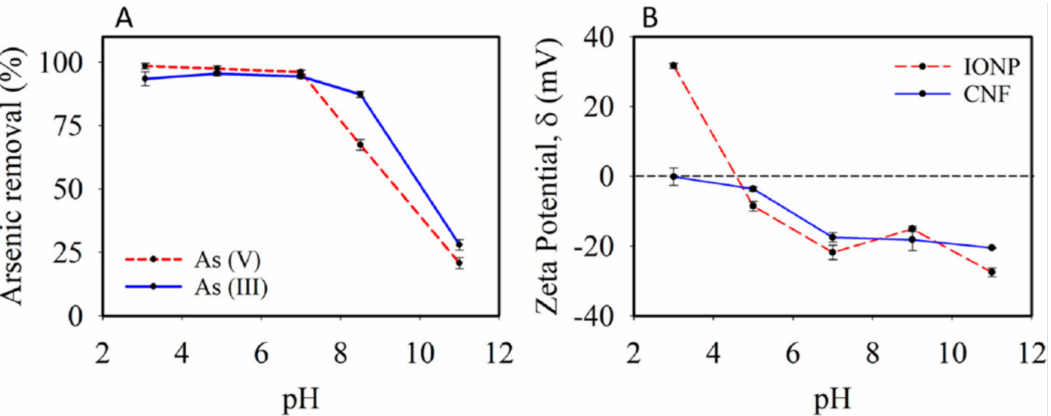
Figure 7. The effect of pH on the removal of arsenic: ( A ) initial arsenic ion concentration and ( B ) zeta potential measurements [130]. Open access: MDPI.